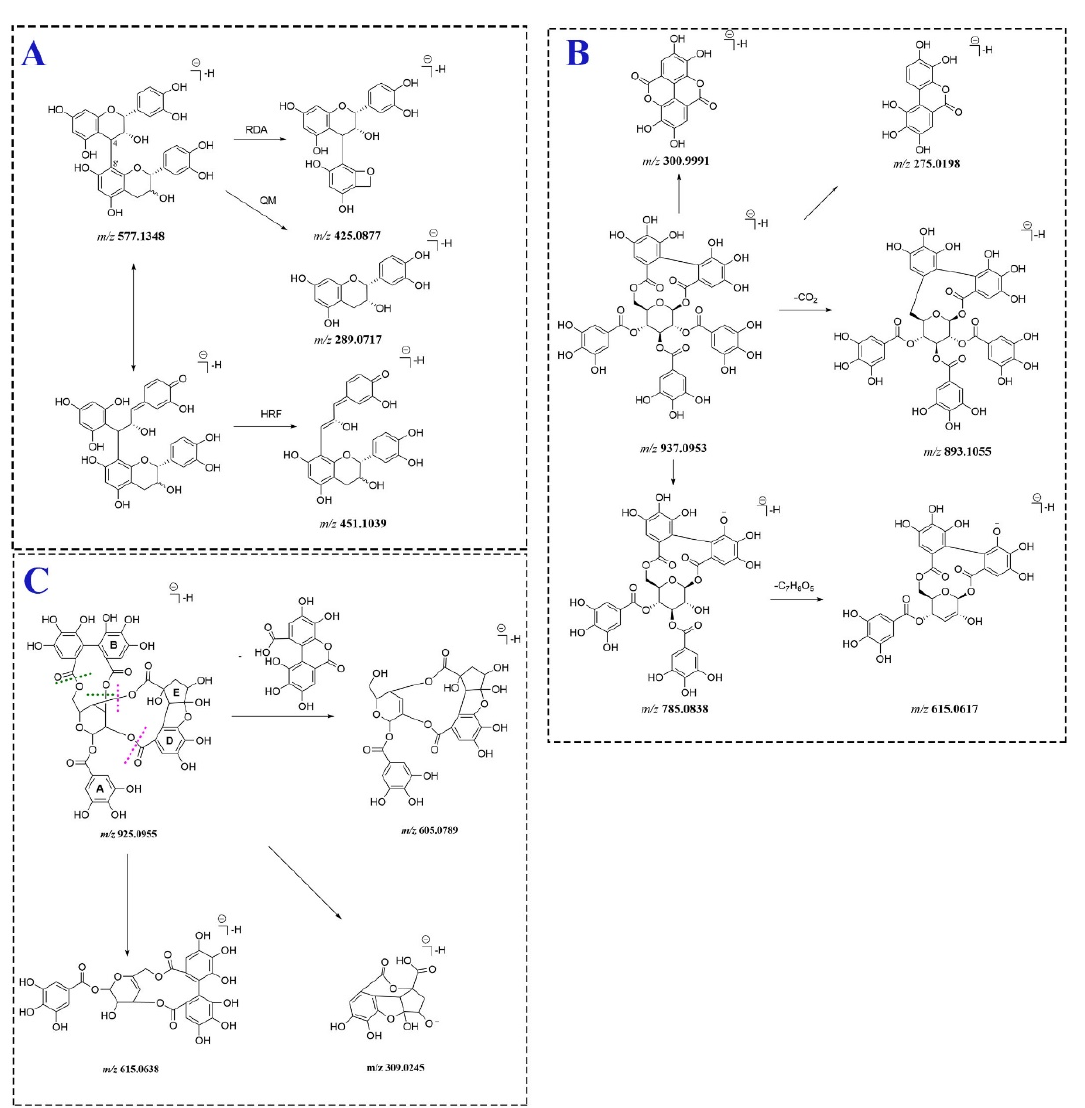
Figure 4. The fragmentation pathways of compounds 25 or 32 ( A ), 64 ( B ) and 33 ( C ). The dotted purple and green lines represent the cleavage positions of compound 33 in MS 2 spectrum. purple and green lines represent the cleavage positions of compound 33 in MS 2